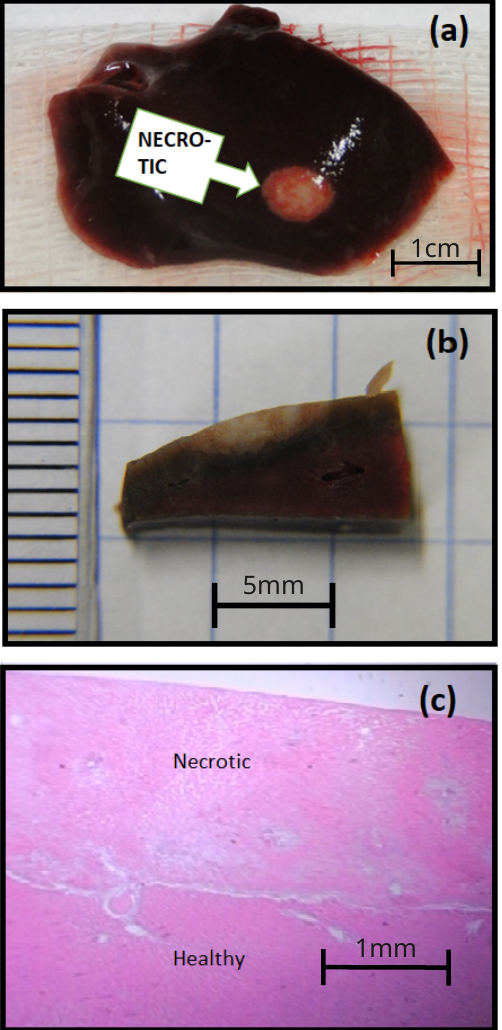
Figure 2. PDT of rat liver with 630 nm laser irradiation, where ( a ) shows the rat liver just after necropsy, ( b ) shows a transversal slice used to measure the depth of necrosis, and ( c ) is a typical histological image showing the transitions between necrotic and healthy